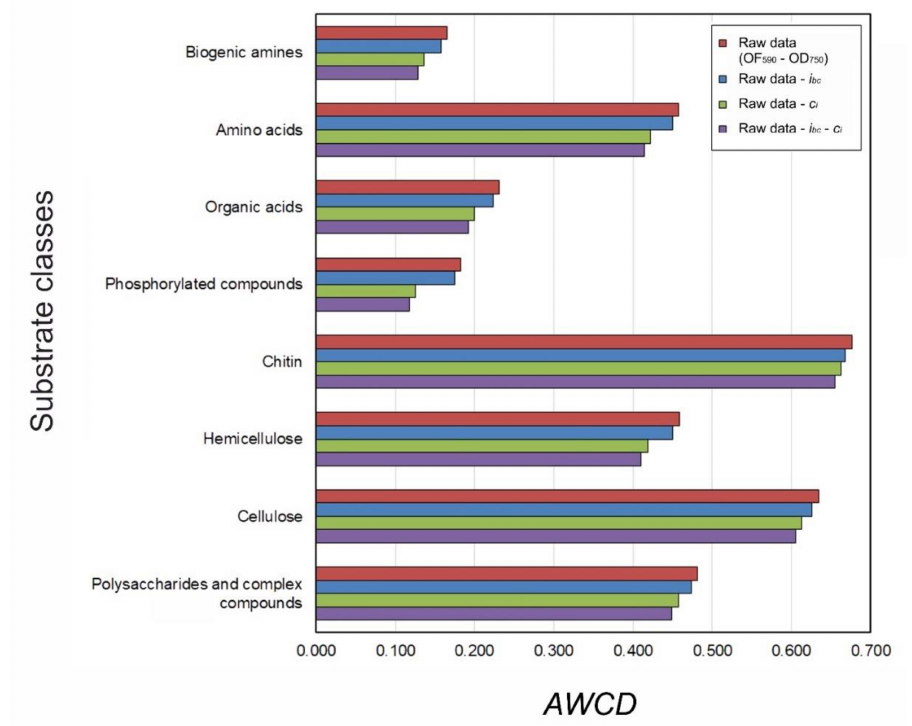
Figure 1. Mean values ( n = 5) of average well colour development ( AWCD ) measured after a 96-h incubation in dilutions (~10 4 CFUs mL − 1 ) of soils from the experimental olive orchard. The values were calculated subtracting from the raw data (OD 590 – OD 750 ) the blank well optical density (OD) reading from the OD value of each substrate well ( i bc ) for each well and successively subtracting the blank-corrected OD reading at time 0 from subsequent blank-corrected readings at ± 12 Xh ( c i ) (in purple). The same methodology was carried out without subtracting the blank well OD reading (in green), without subtracting the blank-corrected OD reading at time 0 (in blue) or without subtracting both (raw data in